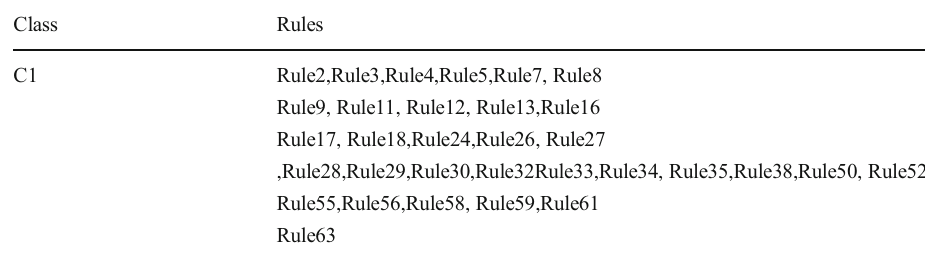
Table 9 The final set of relevant rules Class Rules